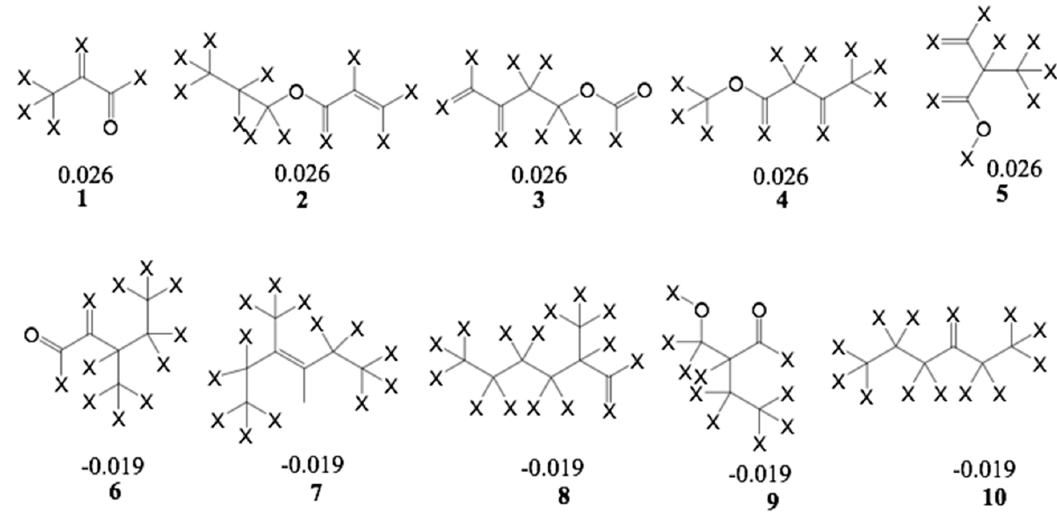
Figure 9. List of fragments with highest positive (1–5) and negative contribution (6–10) to HQSAR Model 8; X atoms are the connectivity flag and are not considered part of fragment. Note that the depicted double bond geometries do not indicate absolute (E/Z) configuration.